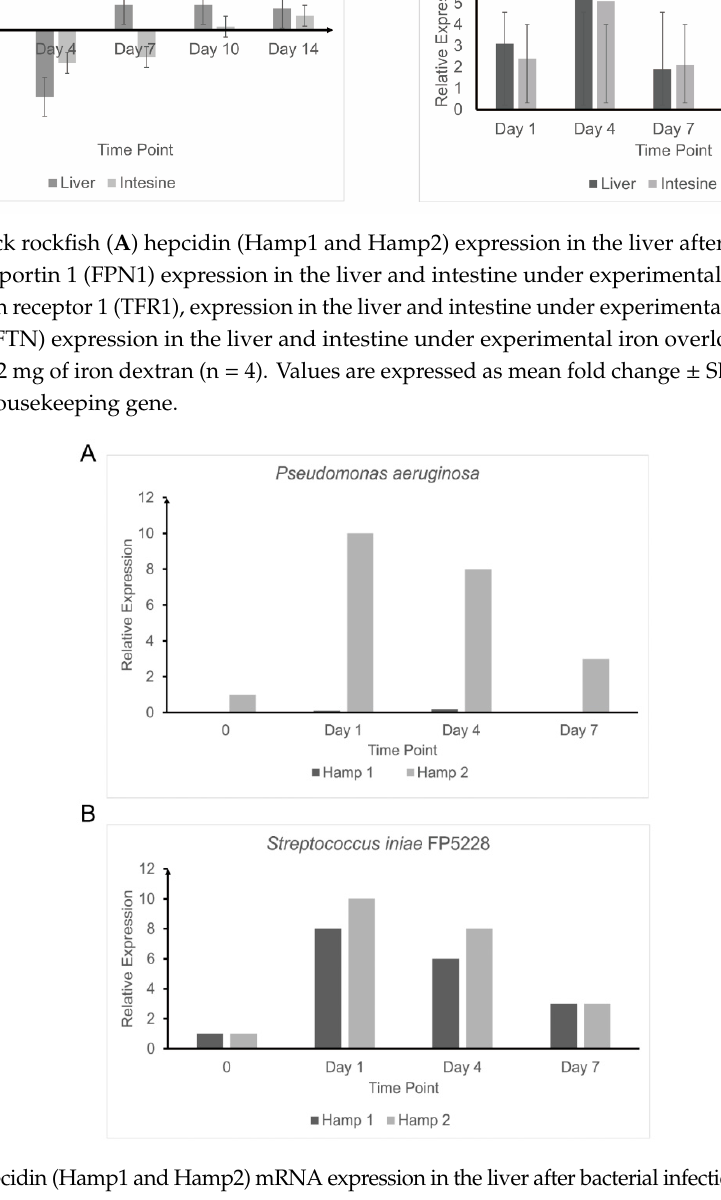
Figure 6. Hepcidin (Hamp1 and Hamp2) mRNA expression in the liver after bacterial infection ( A ) hepcidin (Hamp1 and Hamp2) mRNA expression in the liver after infection with Pseudomonas aeruginosa . ( B ) Hepcidin (Hamp1 and Hamp2) mRNA expression in the liver after infection with Streptococcus iniae